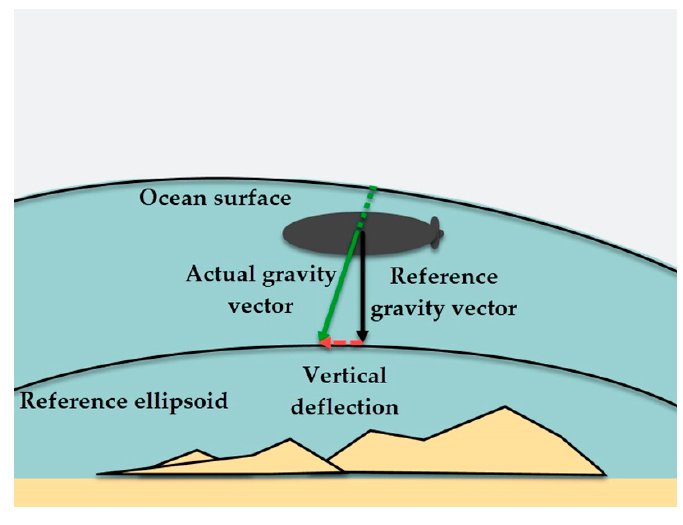
Figure 3. Vertical deflection.